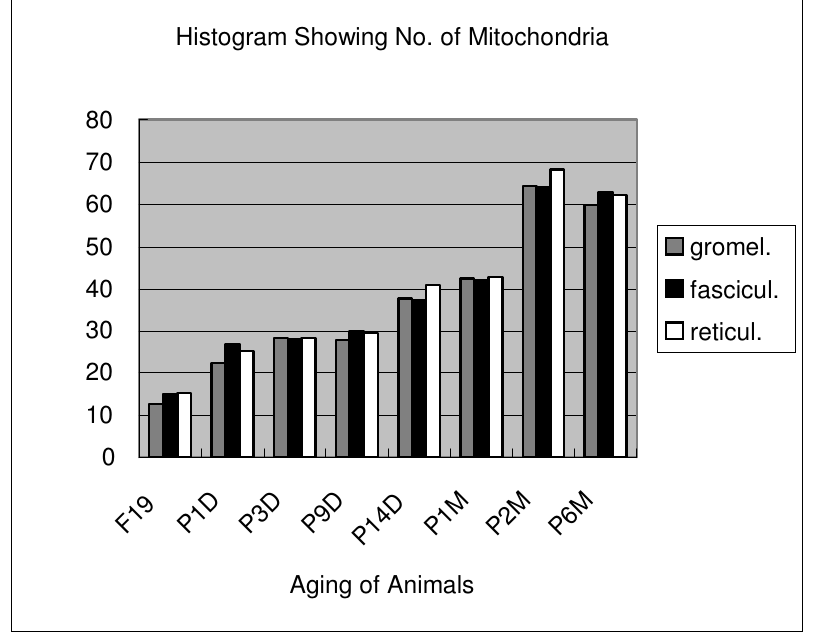
FIGURE 19. Histogram showing the number of mitochondria per each adrenal cortical cell in the three zones of respective animals in eight groups during the development and aging from fetal day 19 to postnatal month 6. The number of mitochondria per cell increased from perinatal stage to old stage at postnatal month 6.